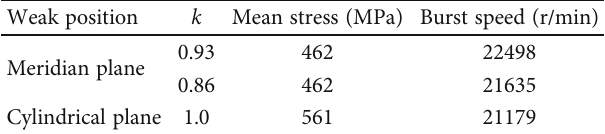
Table 5: Burst speed results from mean stress method.